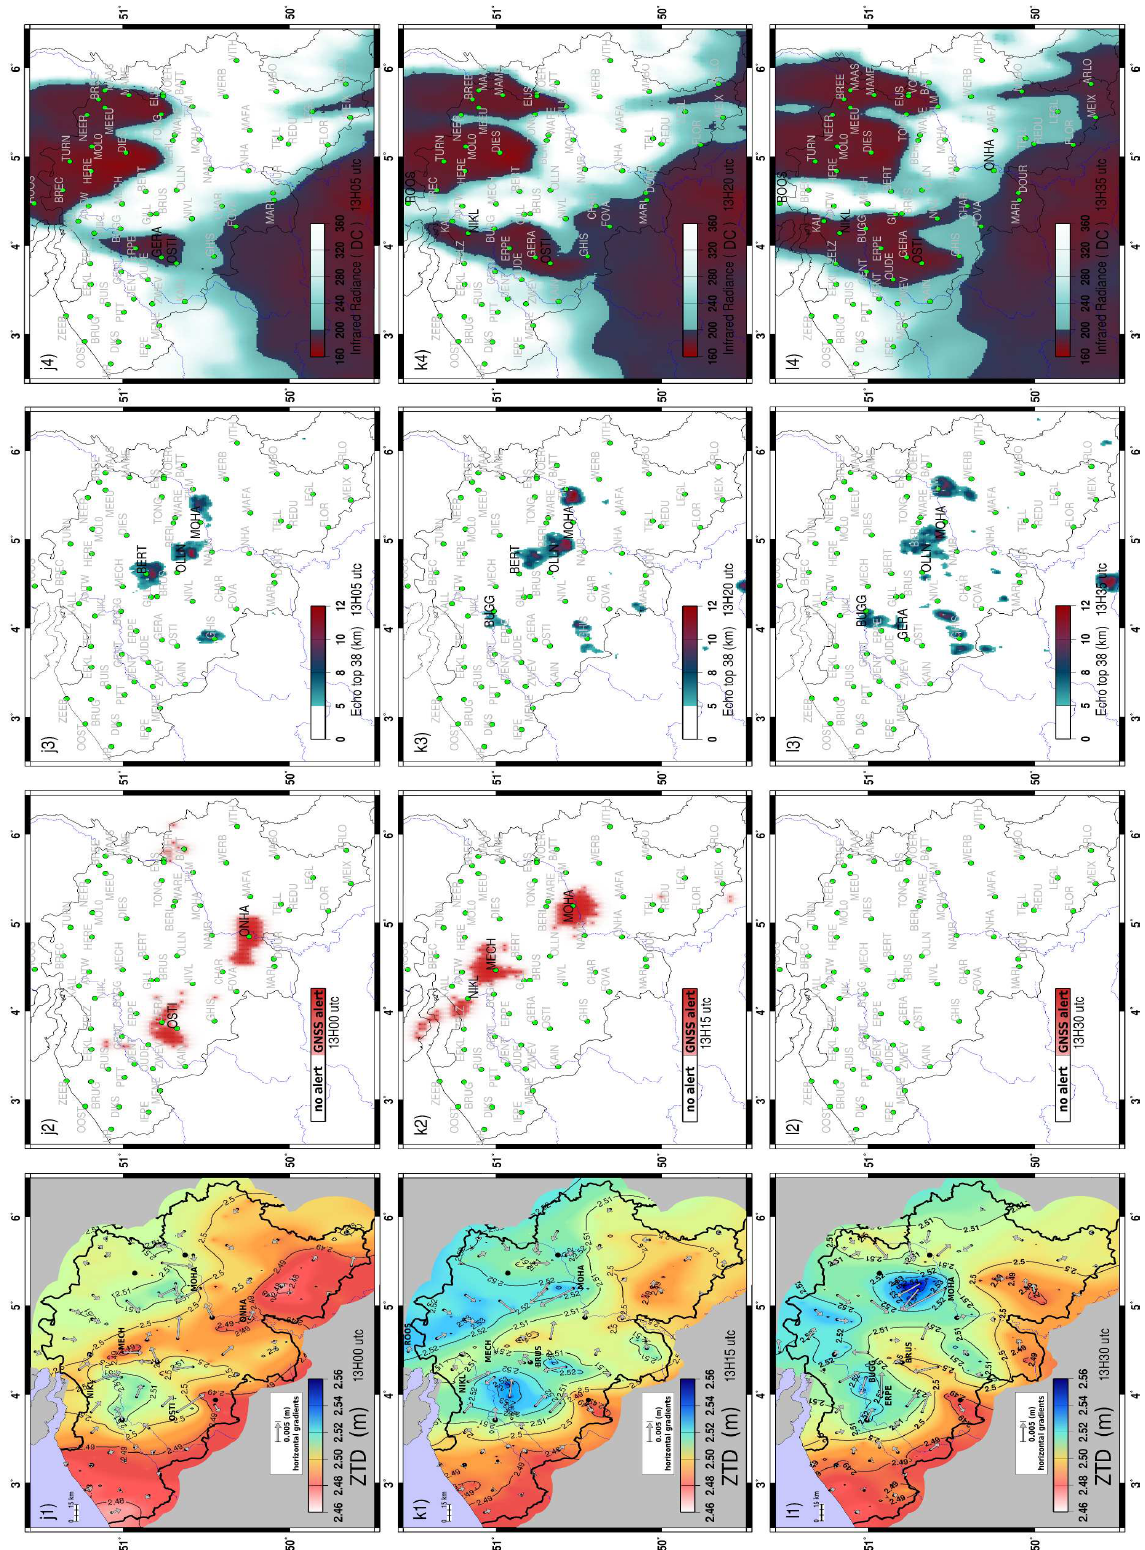
Figure 15. 2D fields of ZTD and horizontal gradients (in m) on the left column, followed by GNSS H 2 O alerts (0 or 1), and by altitudes of the highest 38 dBZ radar echo (in km). The right column shows infrared radiances from SEVIRI in digital counts (DC). See Table 1 for CTT correspondence. There is a time delay of 15 minutes between each 12 lines (GNSS fields start at 10:45 am; echo top radar and SEVIRI radiance start at 10:50 UTC on the 29 th of June